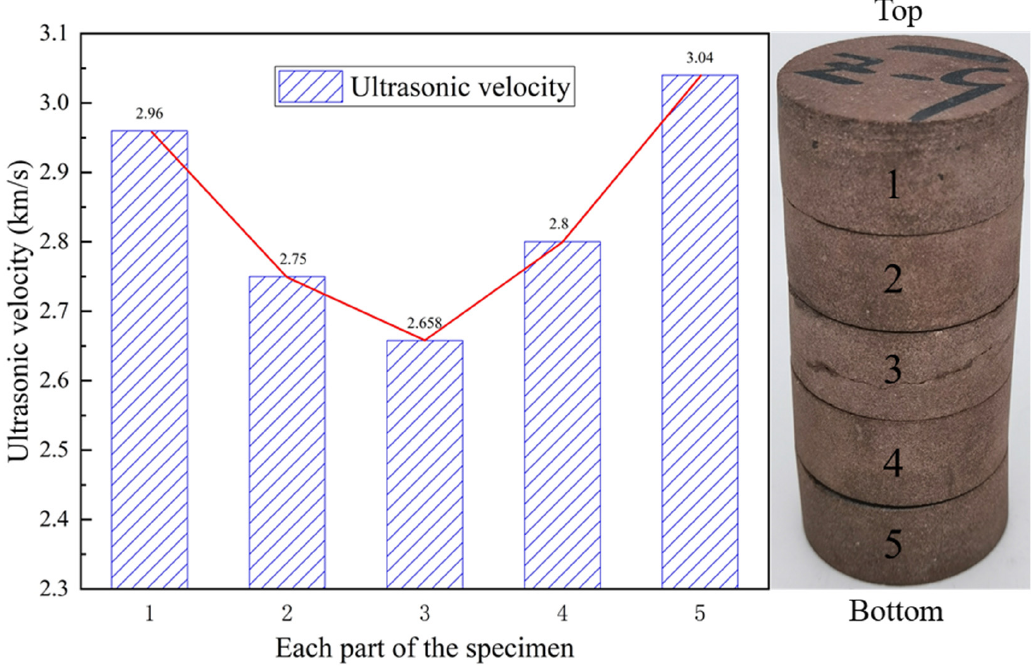
Figure 8. P-wave velocity of each section of the sample after cyclic microwave irradiation.